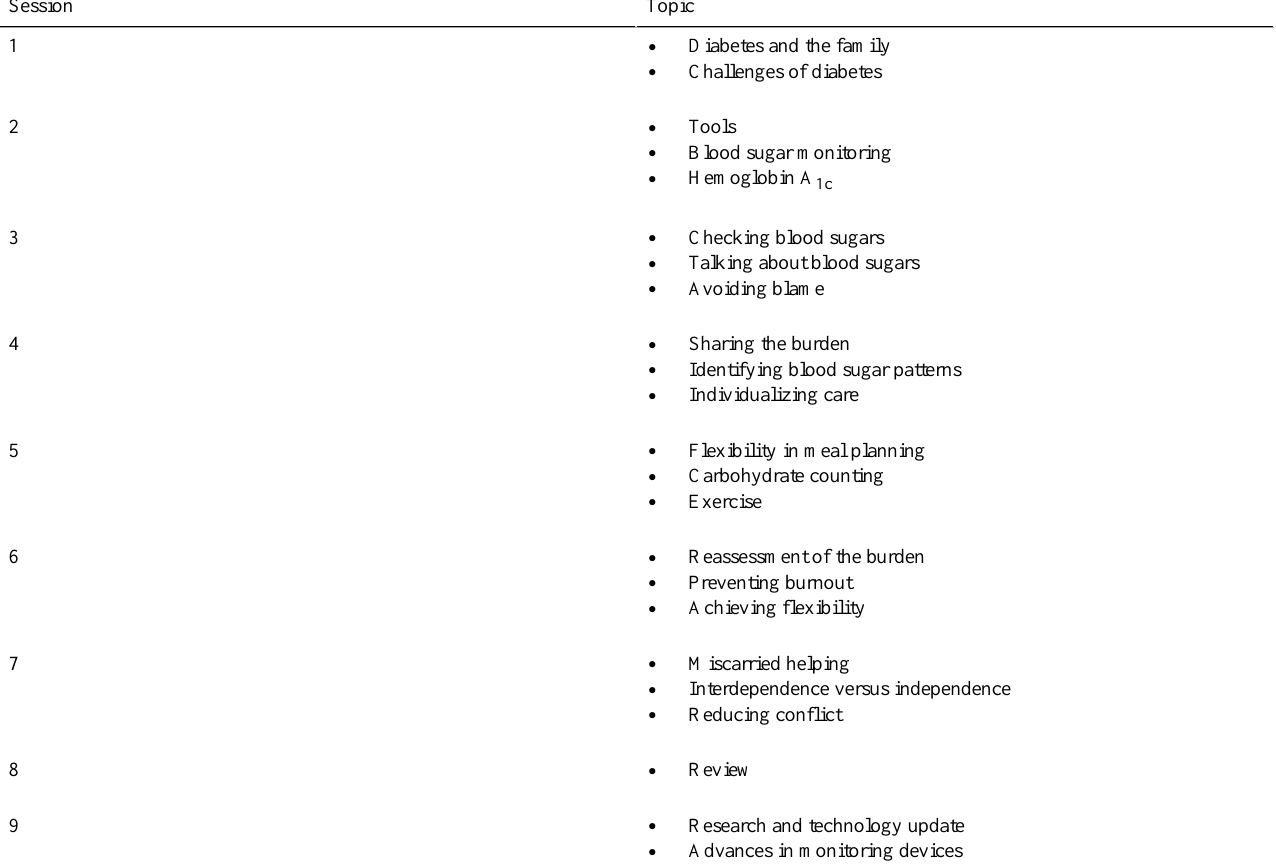
Table 1. Family Teamwork session